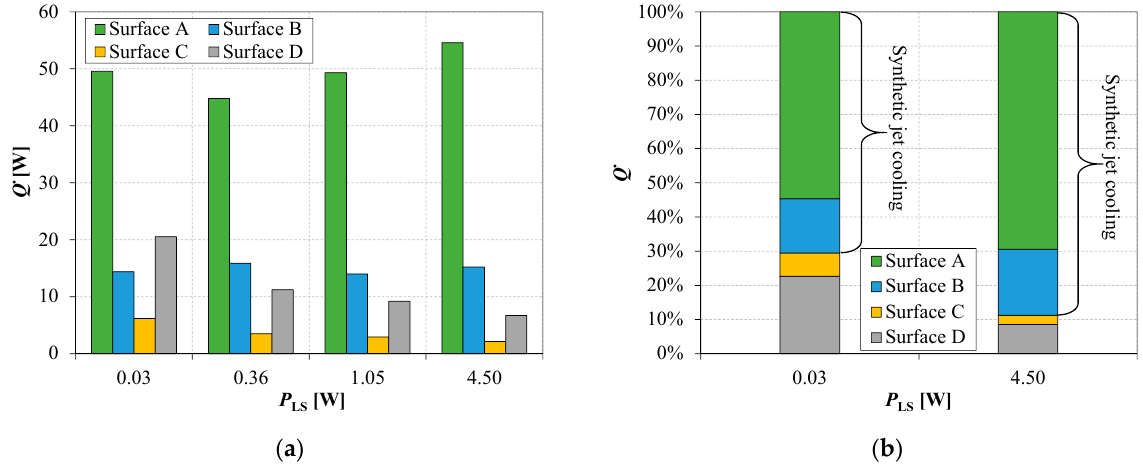
Figure 10. ( a ) Heat dissipated by different surfaces for various values of the input power driving SJA. ( b ) The heat transfer rate dissipated by various surfaces for various input power driving SJA.